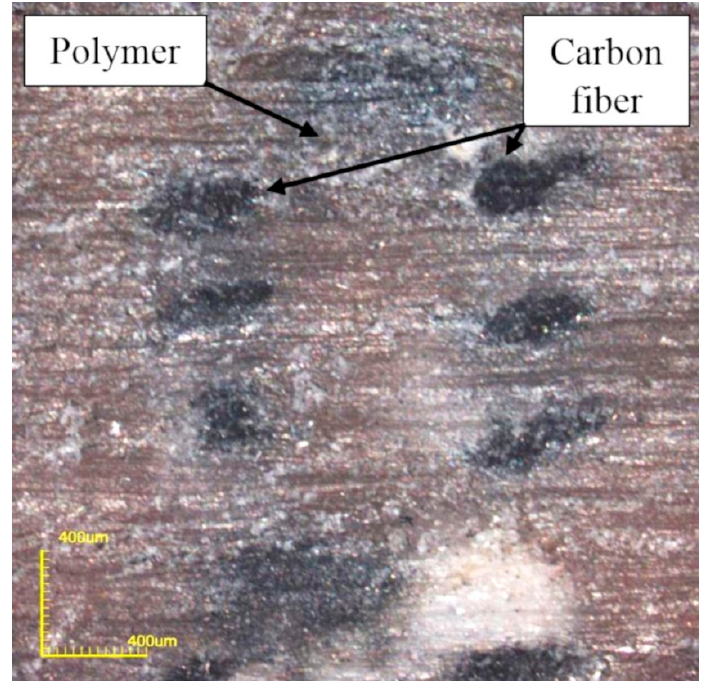
Figure 6. Cross-section of composite across bundles of reinforcing fibers.